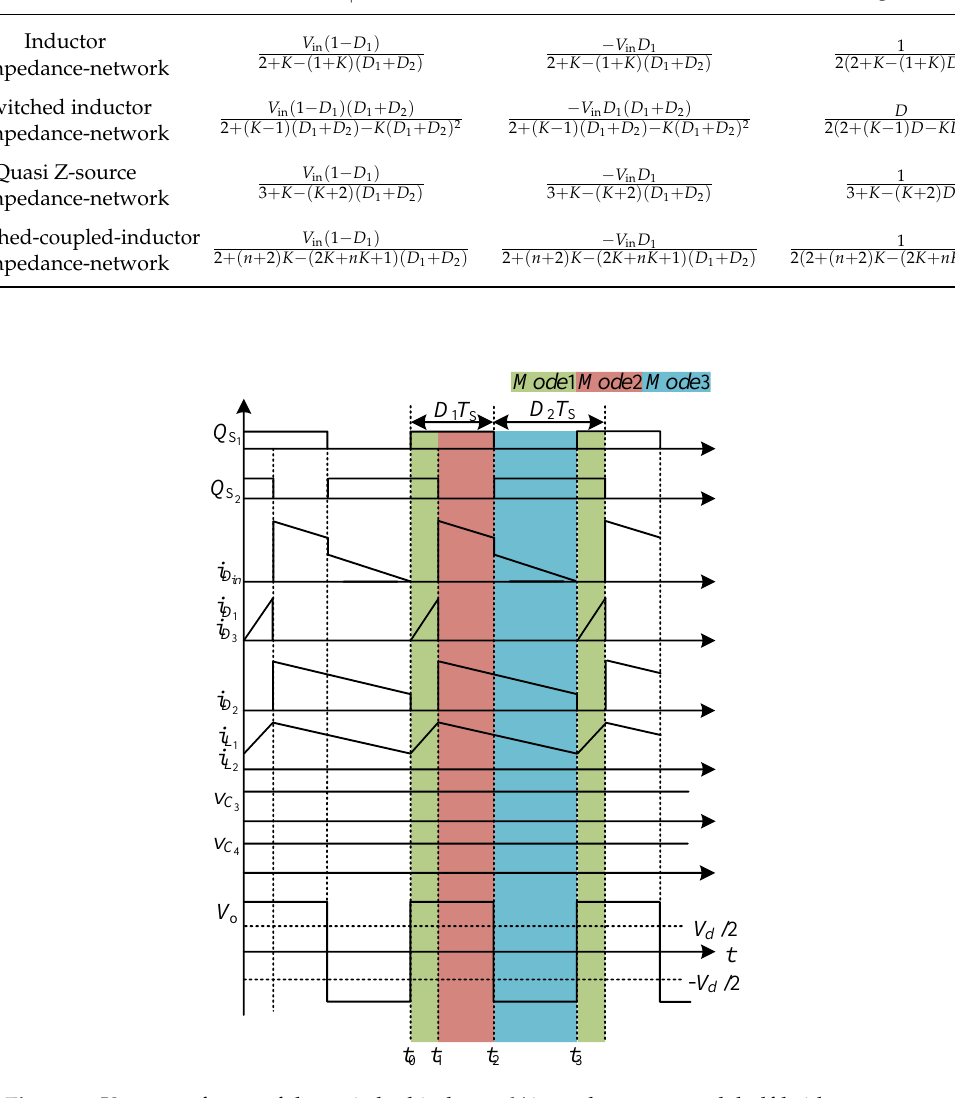
Figure 4. Key waveforms of the switched inductor Y-impedance-network half-bridge